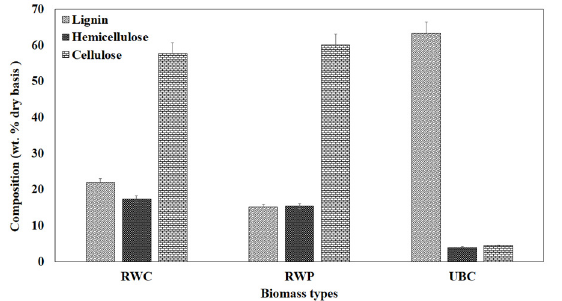
Fig. 2: Compositions of RWC, RWP and